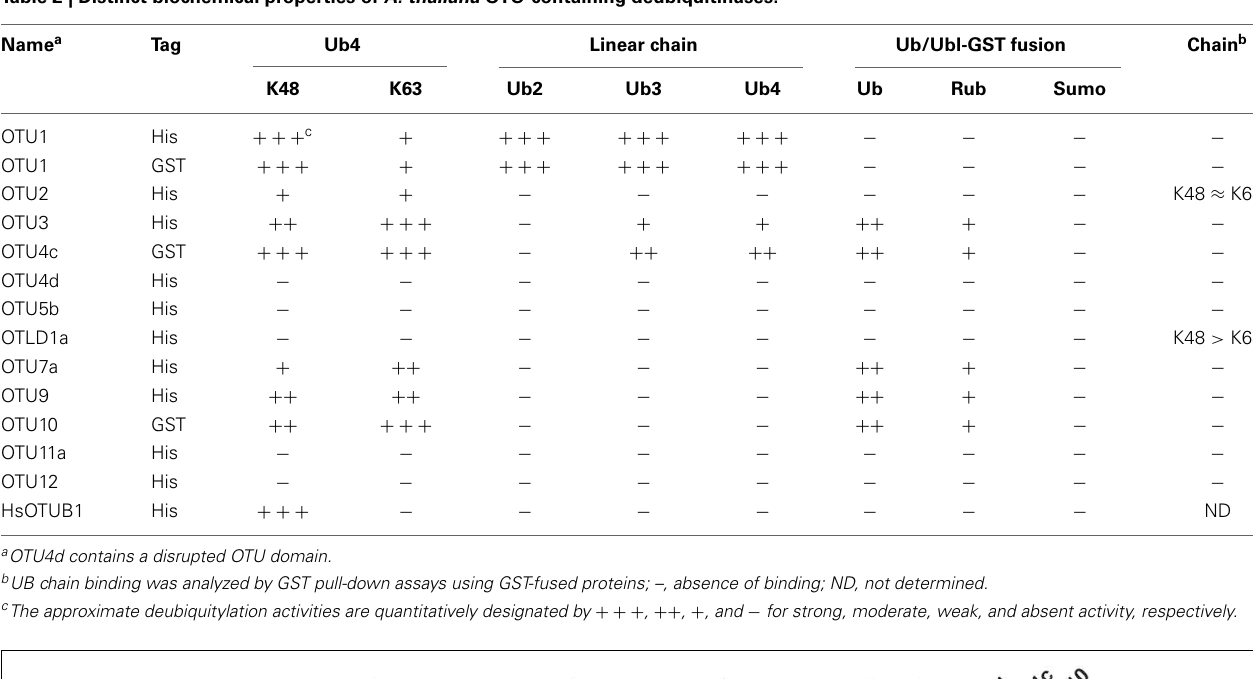
Table 2 | Distinct biochemical properties of A. thaliana OTU-containing